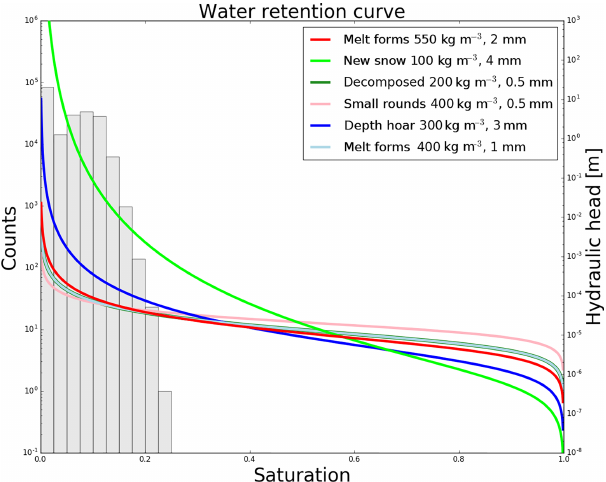
Figure 2. Water retention curve using Yamaguchi et al. (2012) in the Van Genuchten (1980) parameterization. Typical values for density and grain sizes of different snow crystals or grains were chosen to show hydraulic head as a function of saturation for different snow layers that it is applied to in the Richards routine. The density and grain size values were chosen from each crystal type from within a reasonable range that may be found in nature. Background shows a histogram of the simulated data sets’ saturation with a T Crocus = 900s time step before entering the Richards routine (left y axis).